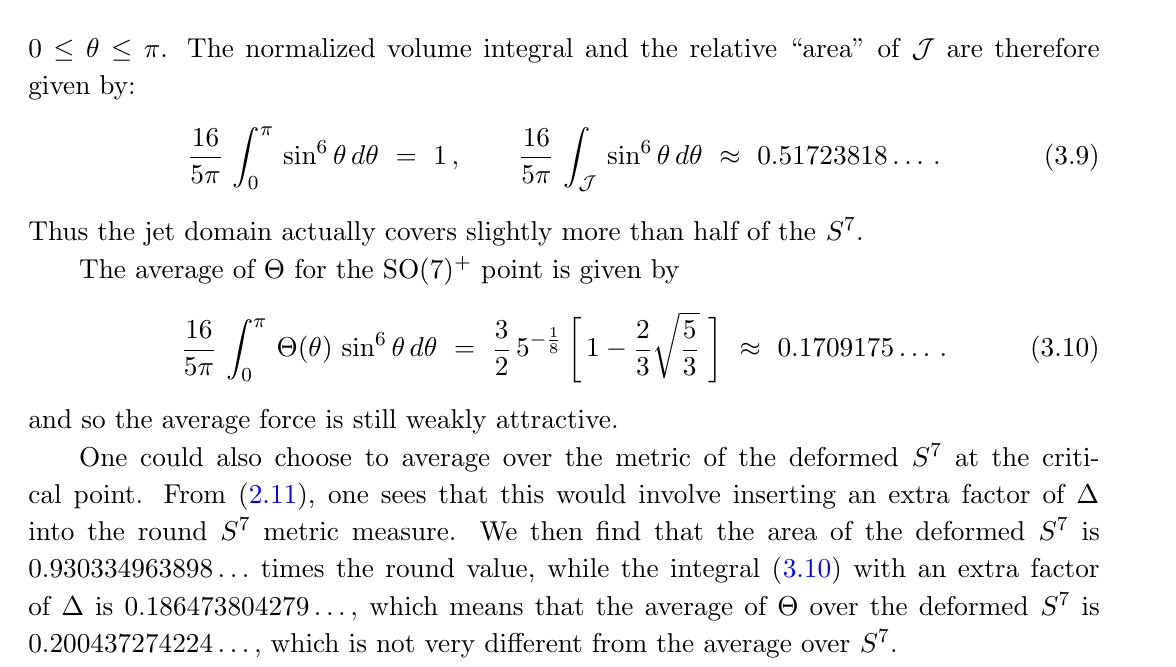
Figure 1 . Plot of (cid:2)( (cid:18) ) for the G 2 (in blue) and SO(7) + (in red) critical points. Note that for G 2 , (cid:2) remains strictly positive while for SO(7) + , (cid:2) becomes negative in a region around (cid:18) = (cid:25) negative region is signi(cid:12)cantly larger than it appears in this plot because of the volume measure factor in